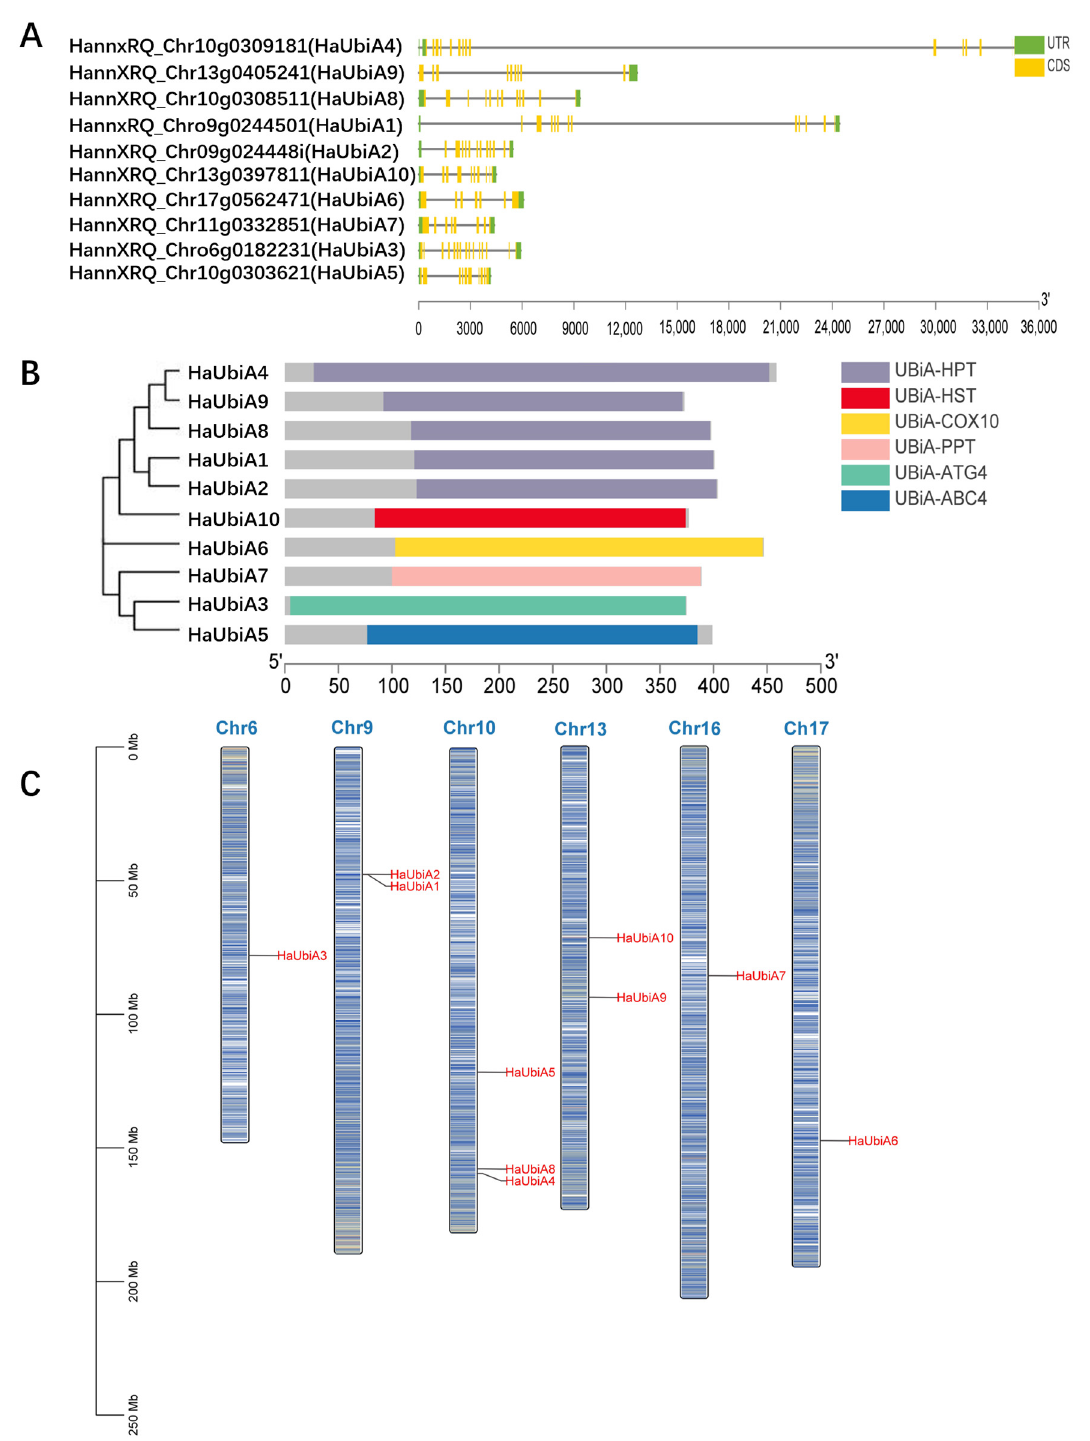
Figure 1. Phylogenetic analysis and chromosomal location of UBiA family genes in H. annuus . ( A ) HaUBiA gene structures. The green part is the untranslated region, and the yellow part represents the coding sequences. ( B ) Phylogenetic trees of HaUBiAs were constructed by the neighbor-joining method with 1000 bootstrap replications. The grey section indicates the full length of the protein. The UBiA genes conserved domain were presented in different colors. ( C ) Chromosomal locations of 10 HaUBiA genes. The scale bar on the left indicates the length (Mb) of Helianthus annuus chro- mosomes.